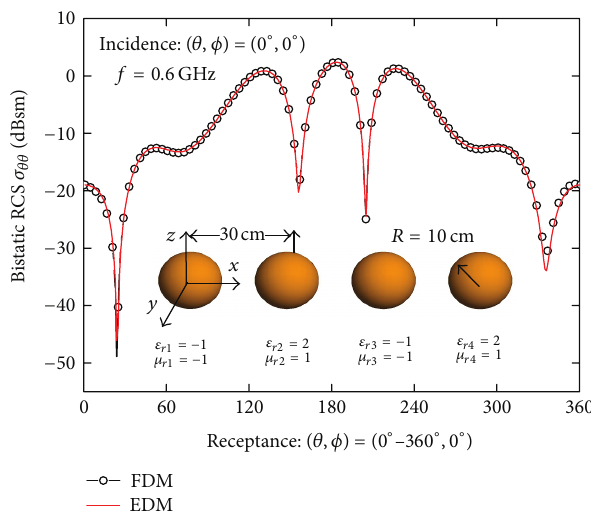
= 2, 𝜇 = 2 illuminated by a plane wave with 𝑟 𝑟